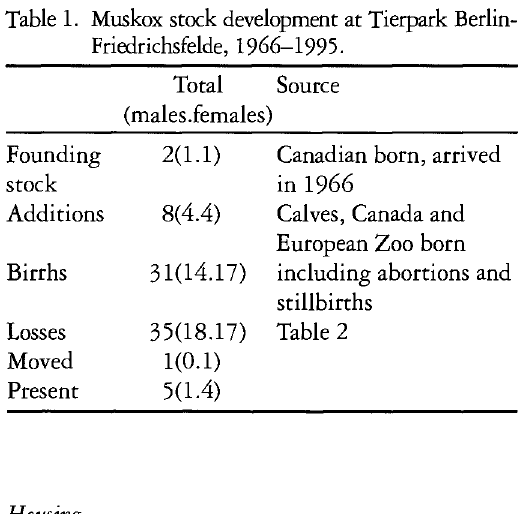
Table 1. Muskox stock development at Tierpark